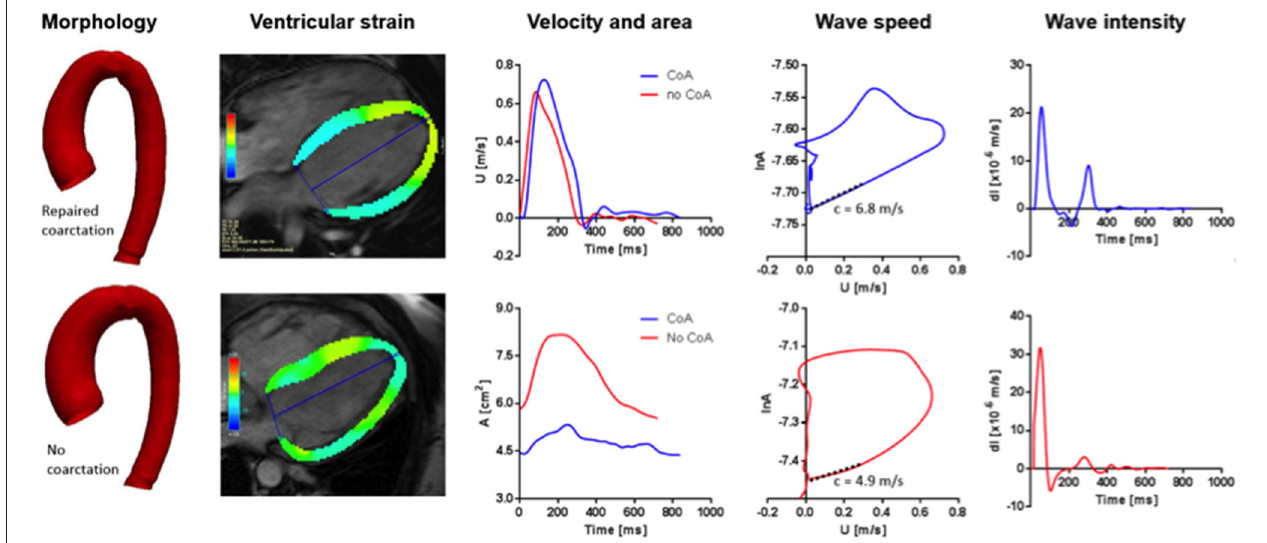
FIGURE 1 | From left to right: Aortic arch template of patients with BAV and repaired aortic COA (upper) and isolated BAV (lower); four-chamber view for GLS analysis in the diastole (upper) and systole (lower); velocity (upper) and area (lower) curves derived from phase-contrast analysis at the level of the ascending aorta; wave speed in patients with repaired COA (upper) and isolated BAV (lower); examples of wave intensity analysis patterns in a patient with repaired COA (upper) and isolated BAV (lower).